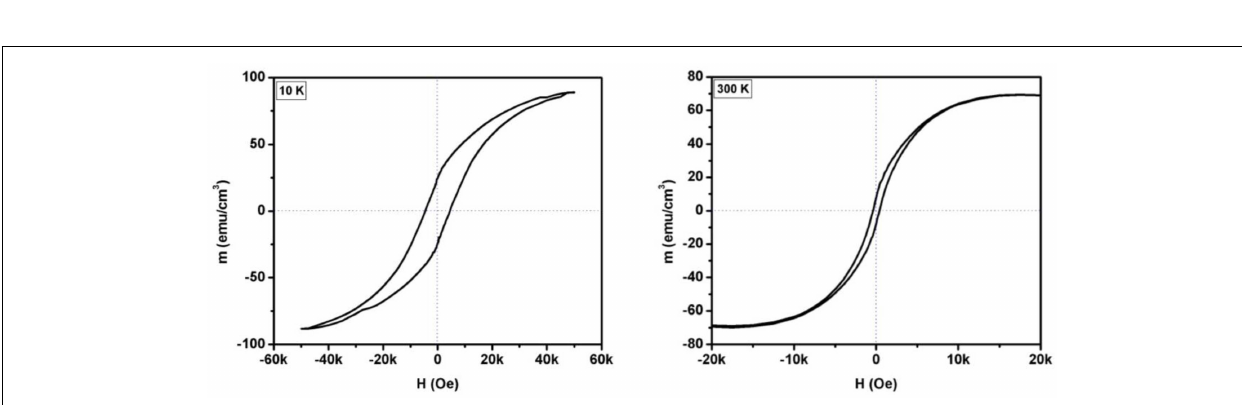
FIGURE 6 | M vs. H plot for SnFe 2 O 4 film at different temperatures .